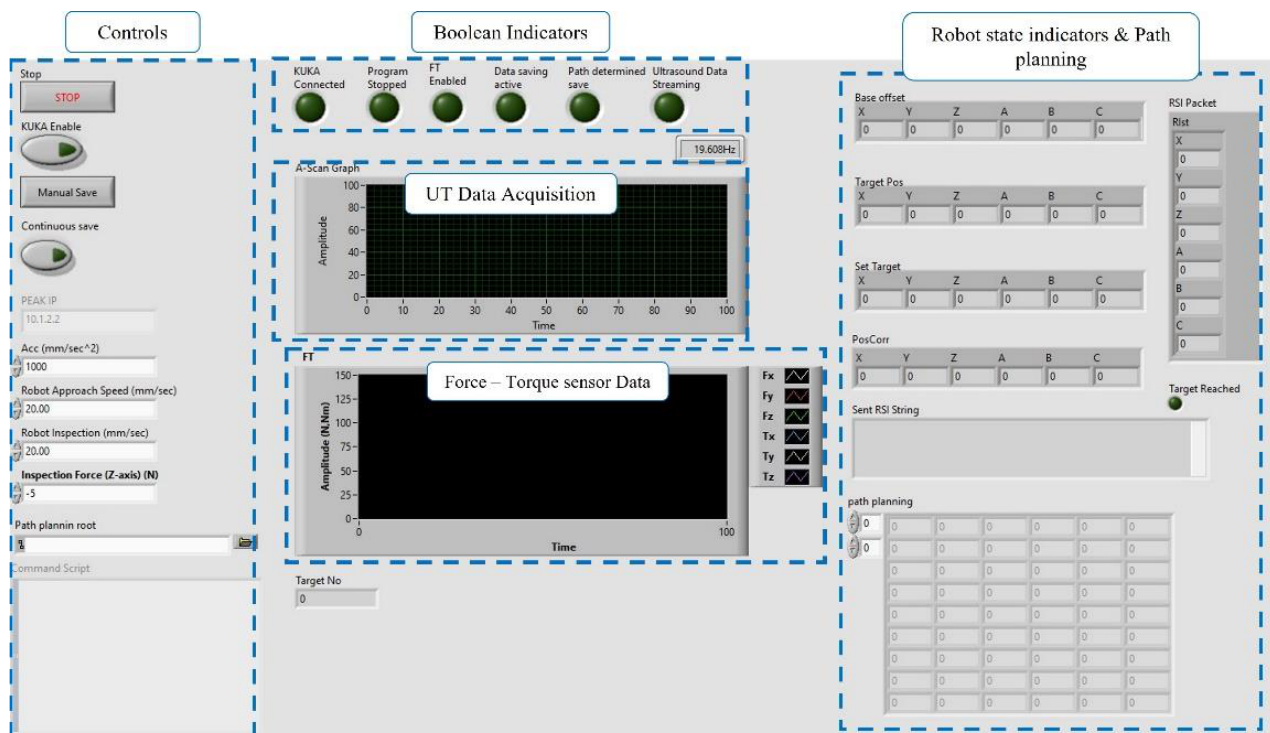
Figure 3. LabVIEW GUI for NDE process control and monitoring.